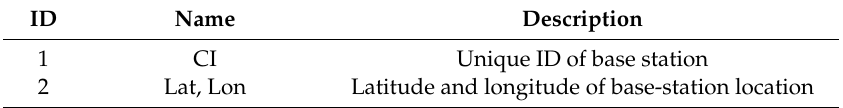
Table2. TheinnerstructureofGlobalSystemforMobileCommunication(GSM)engineeringparameters.